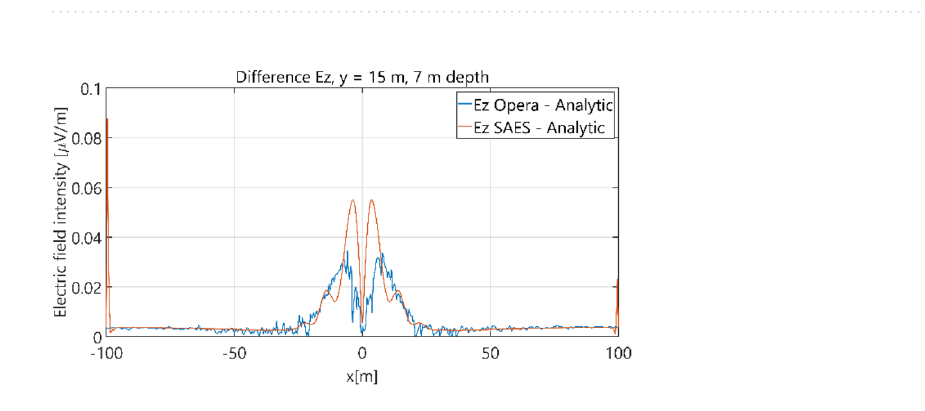
Figure 29. Distribution of differences between E z valuies obtained from Opera (FEM) and SAES (BEM) models and the analytical model ( y = 15 m, z = − 7 m, case II).